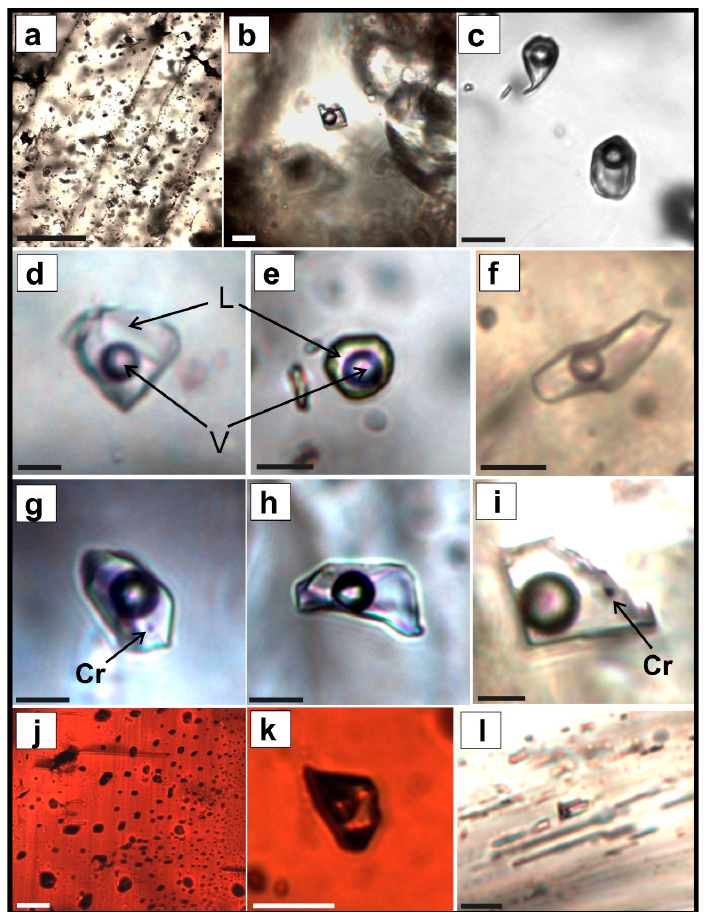
Figure 5. Photomicrographs of fluid inclusions from quartz-hubnerite veinlets of the Inkur deposit. ( a ) A quartz grain with trails of secondary inclusions; ( b ) primary single fluid inclusion in quartz grain; ( c – f ) primary two-phase fluid inclusions in quartz grains; ( g – i ) primary fluid inclusions with small dark phases (shown by arrows) in fluorite; ( j ) a group of vapor FIs in a hubnerite grain; ( k ) primary single two-phase FI in hubnerite; ( l ) a group of small FIs in muscovite. Cr—small dark solid phases, L—liquid, V—vapor. The scale bar length is 10 μ m, for photo ( a ) 100 μ m. In rare fluorite grains, there were found primary FIs, usually single (~15–25 μ m in size), which often (except for the vapor phase and the aqueous solution) contained a small dark phase (Figure 5g,i) of unknown composition that could not be identified by Raman spectroscopy. The vapor phase typically occupied 25% of the inclusion volumes.